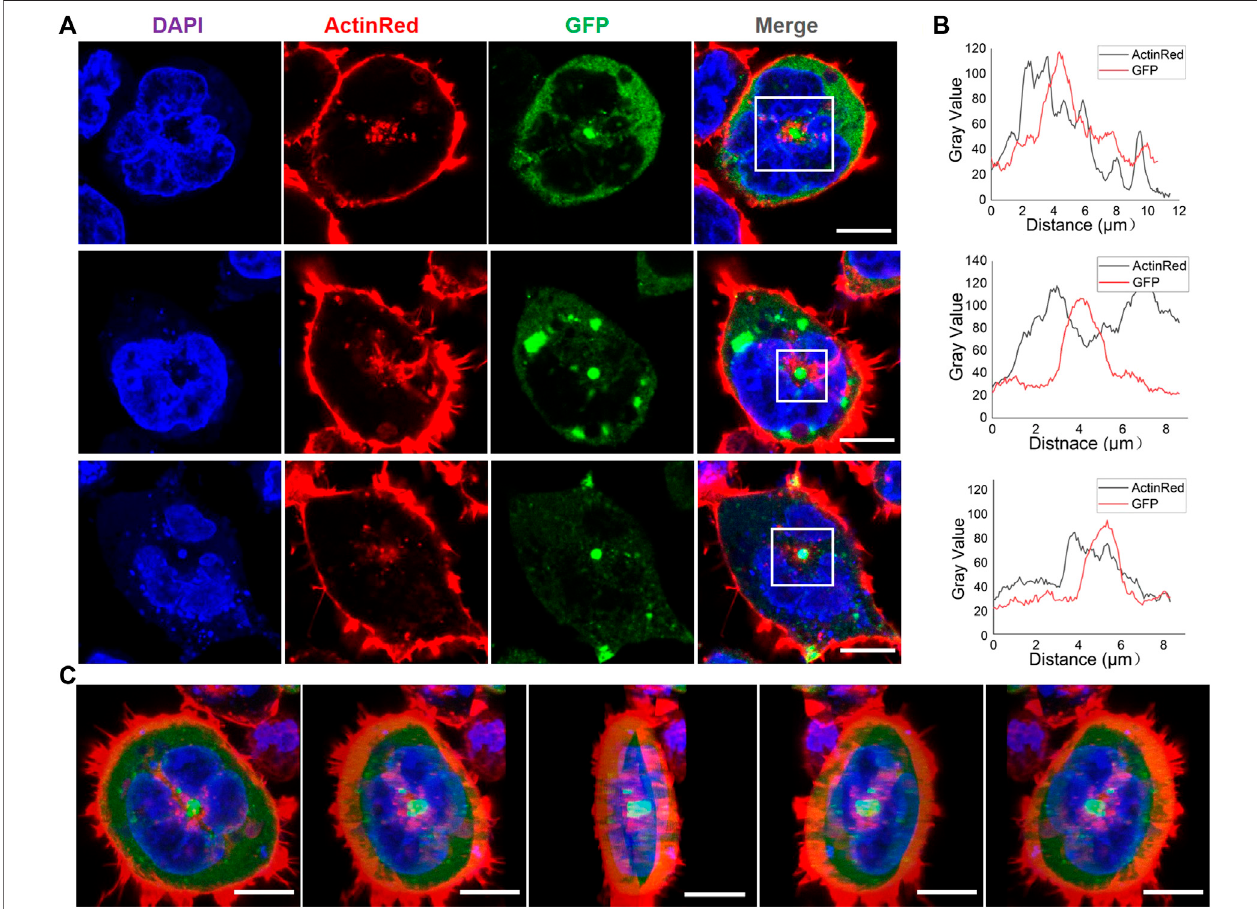
FIGURE5| AppearanceofsphericalRfA1condensatesinthecenteroronthecentralaxisoftransfectedcells. (A) RfA1condensateslocatedinthecenteroronthe centralaxisofcells.NucleiandactinarestainedwithDAPI(blue)andActinRed555(red),RfA1areindicatedbytandemEGFP(green),scalebars=10 μ M. (B) Statisticsof fl uorescence signal distribution in selected areas. (C) 3D images of a transfected cell, with green RfA1 condensates located in the center, scale bars = 10 μ M (see Supplementary Movie S2 ).